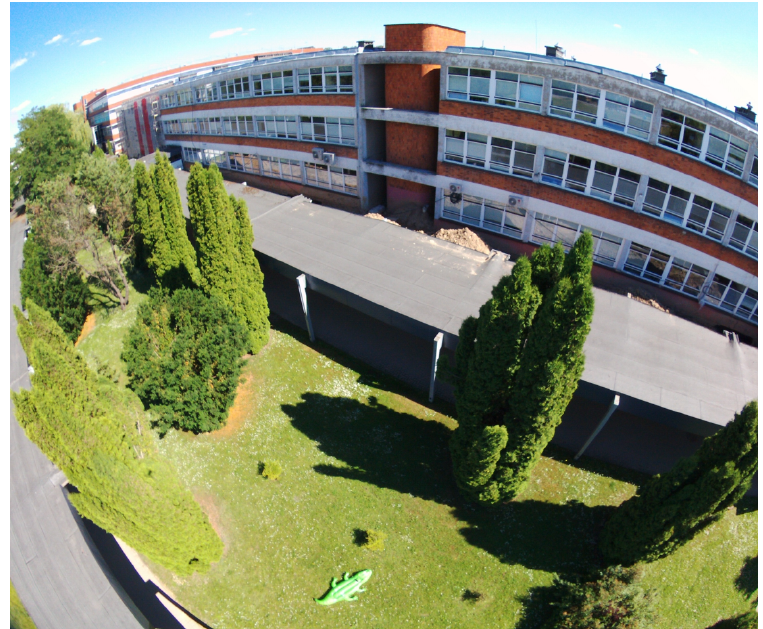
Figure 3. Example image taken from the drone camera as an input data to neural network